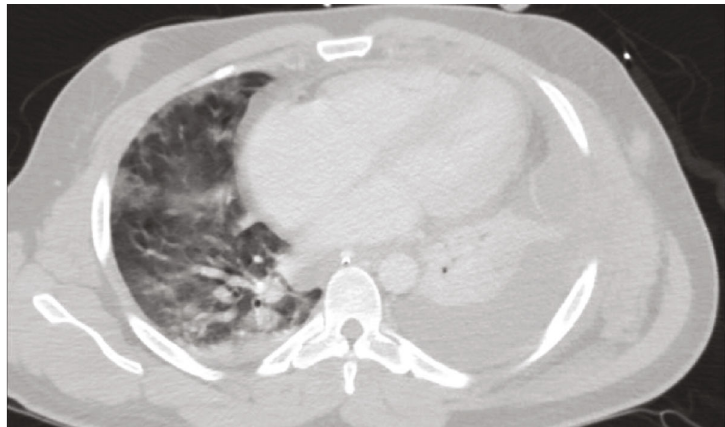
Figure 3: CT chest shows left-sided pleural e ff usion with loculations and atelectasis. Nodular groundglass opacities are present in the right upper and middle lobes. There is a demonstration of a small pericardial e ff